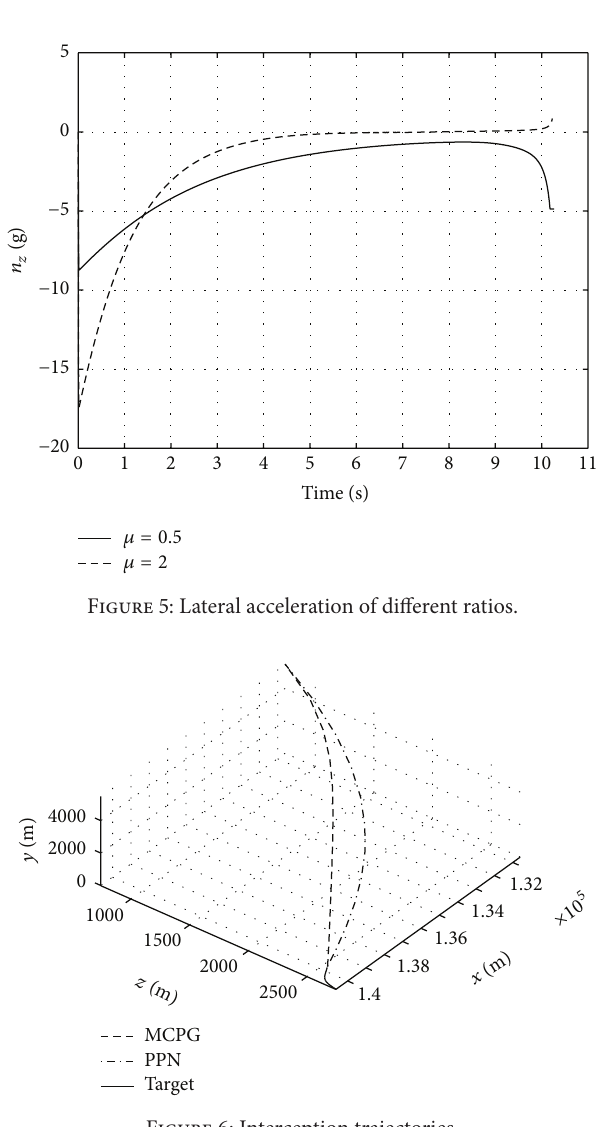
Figure 6: Interception